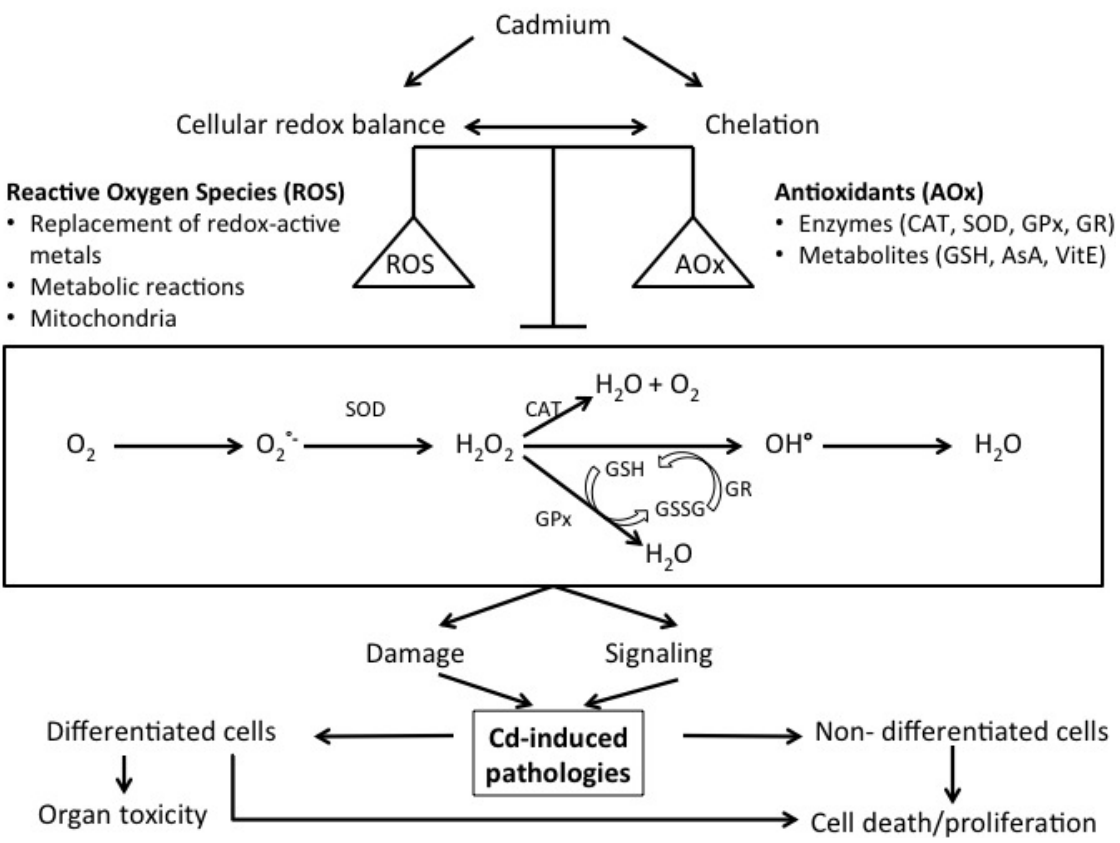
Figure 1. Simplified overview of the components involved in cellular Cd-induced oxidative stress. Reactive oxygen species (ROS); antioxidants (AO superoxide dismutase (SOD); glutathione peroxidase (GP glutathione (GSH); glutathione disulphide (GSSG); ascorbic acid (AsA); vitamin E